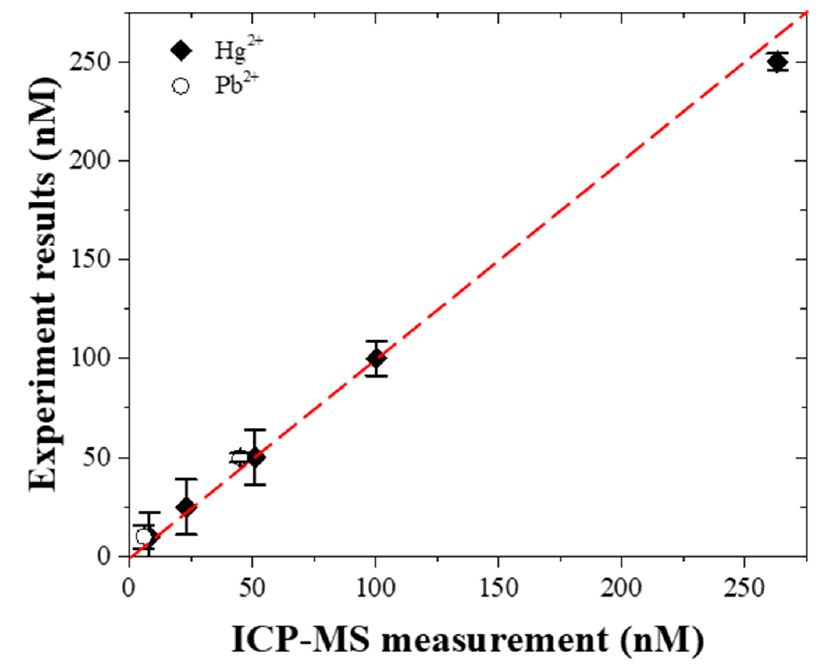
Figure 6. Comparison of results obtained by the ICP-MS and the present microfluidic device ( n = 5). To verify the selectivity of the proposed aptamer detecting the Hg 2+ and Pb 2+ ions simultaneously, the GO/aptamer (GO + FAM(Hg 2+ ) + HEX(Pb 2+ )) solutions were injected into the lower inlet of the microfluidic device, while a mixture of the Hg 2+ and Pb 2+ samples with concentrations of 10, 100 and 1000 nM, respectively, was injected into the upper inlet. Figure 7a,b show the detected fluorescence images for Hg 2+ and Pb 2+ samples of 10 nM and 100 nM, respectively. The fluorescence images reveal that the proposed aptamer is able to detect both ions simultaneously, and the fluorescence intensity is proportional to the concentration. The corresponding fluorescence intensity measurements are shown in Figure 7c. For both probes, the fluorescence intensity shows good recovery performance for all values of the concentration (i.e., low, medium and high). In other words, even though the fluorescence recovery reduces as the concentration of the competing metal ions increases, the device still retains the ability to discriminate the target ions. In addition, control experiments were performed using several other bivalent metal ions, namely Co 2+ , Ca 2+ , Mg 2+ and Cu 2+ ions. Figure 7d shows the detection results obtained for a mixture of the Hg 2+ + Pb 2+ ions containing an additional 10 µ M of Co 2+ , Ca 2+ , Mg 2+ and Cu 2+ ions, respectively. It can be seen that the competing ions have only a minor effect on the measured fluorescence change despite their relatively high concentration. Notice that our concentration of Hg 2+ and Pb 2+ is 10 nM, which is much more diluted than those of other metal solutions (10 µ M), i.e., a 1000-times difference in concentration. Therefore, the intensity of Hg 2+ and Pb 2+ is not significantly different from other solutions. In other words, the selectivity of the proposed sensor for Hg 2+ and Pb 2+ ion detection is further